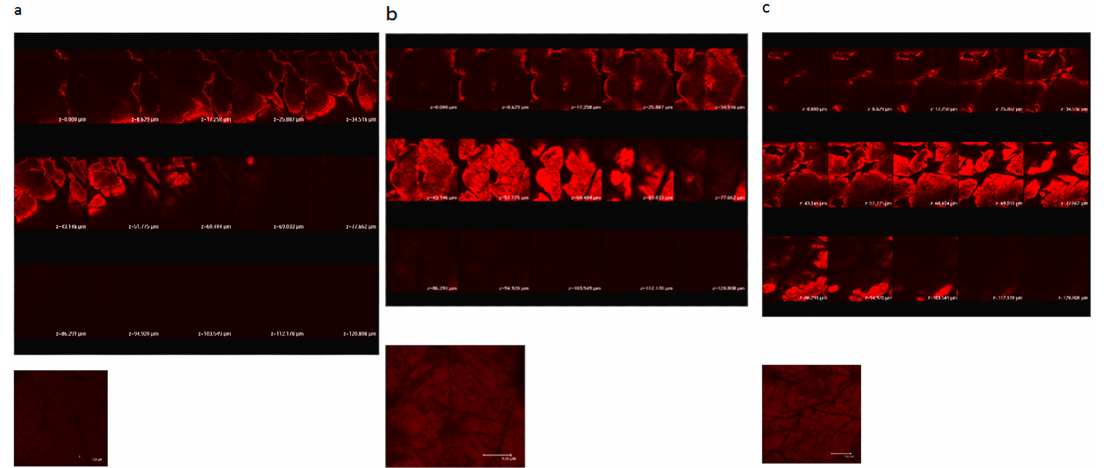
Figure 1. Confocal laser scanning microscopic (CLSM) micrographs of porcine skin after in vitro topical administration of rhodamine B via the skin by laser pretreatment: ( a ) Non-treatment group; ( b ) Fractional CO 2 laser treatment at 12 mm, 5 W; ( c ) Fractional CO 2 laser treatment at 12 mm, 9 W (original magnification, 20×). The skin specimen was viewed by CLSM at 8- μ m increments through the Z -axis. The images below the photographs of the 15 fragments are the sum of all fragments.